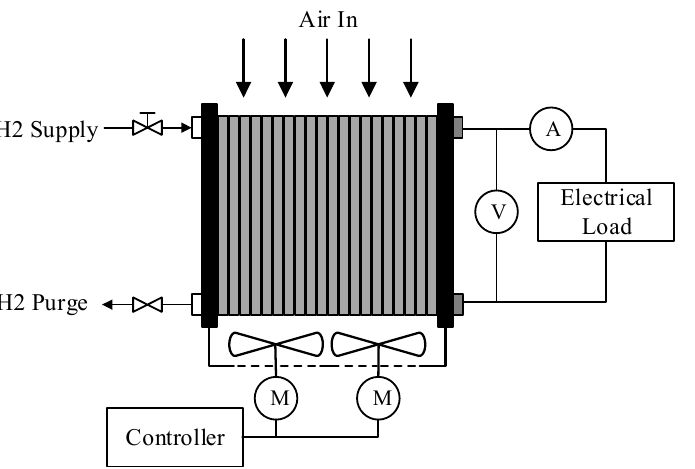
Figure 1. Schematic diagram of OC-PEMFC.